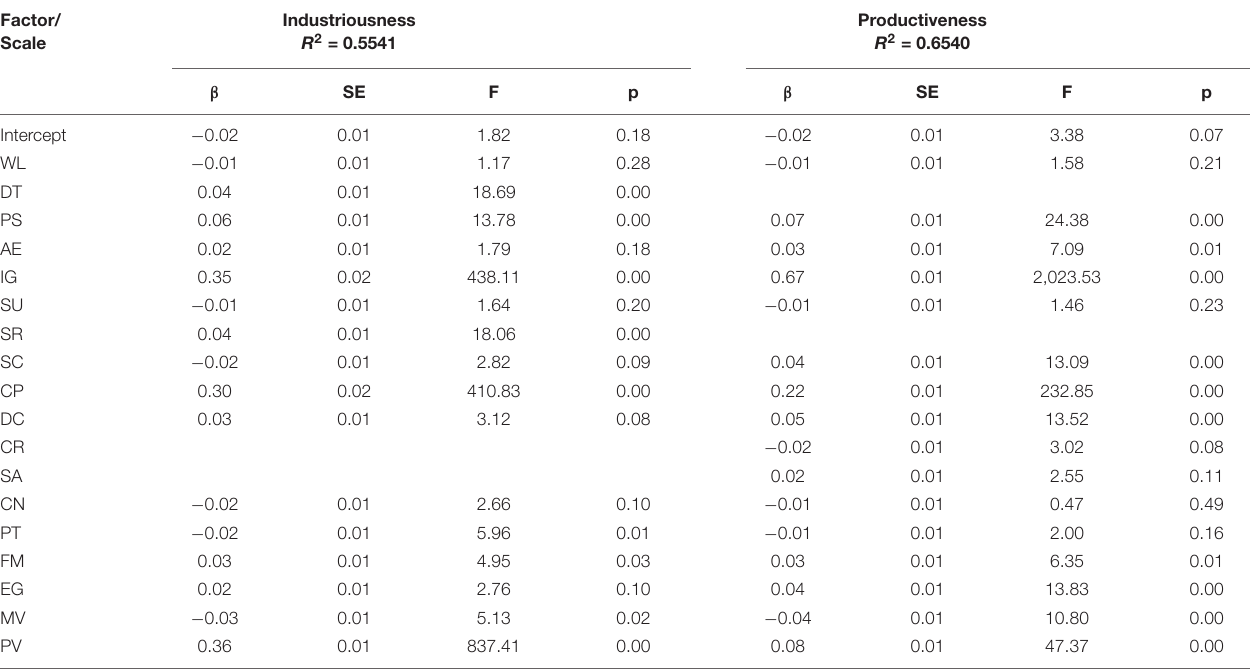
Data for Industriousness and Productiveness as criterion variables are incomplete. Underneath Table 2 , and underneath Table 6 .